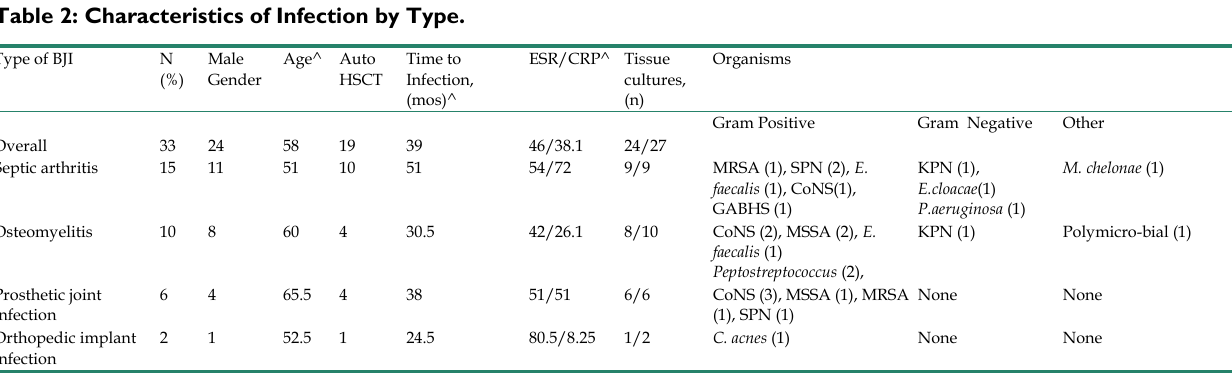
Table 2: Characteristics of Infection by Type. Type of